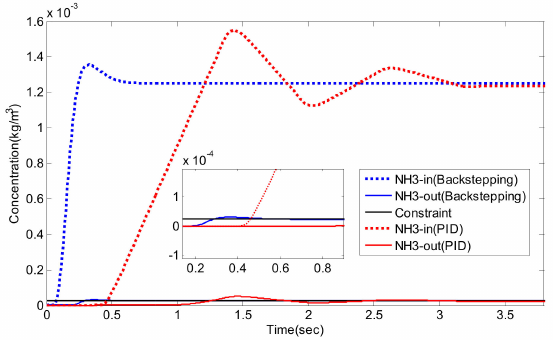
Figure 22. NO / NO 2 = 1 / 1, NH 3 concentration before and after the SCR